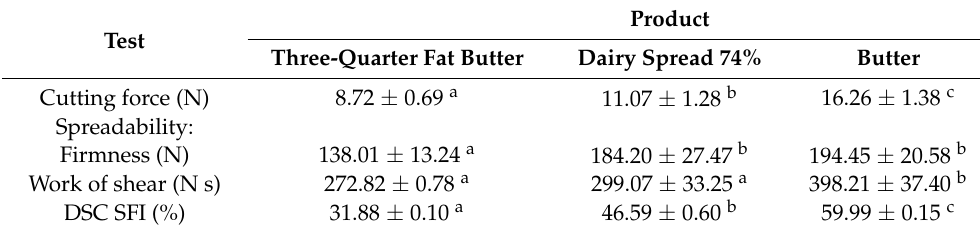
Table 3. Texture and solid fat index of the analysed products at 4 ◦ C.